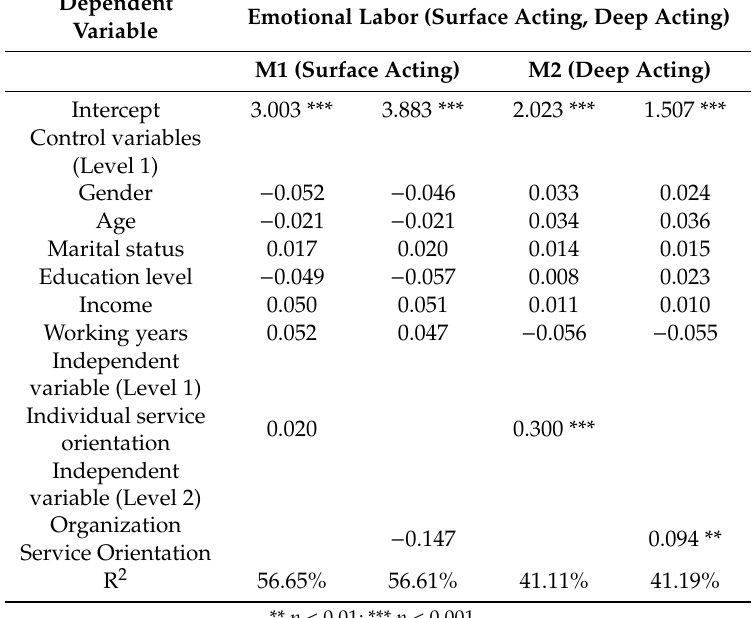
Table 8. The mediating role of individual social capital (the first conditional